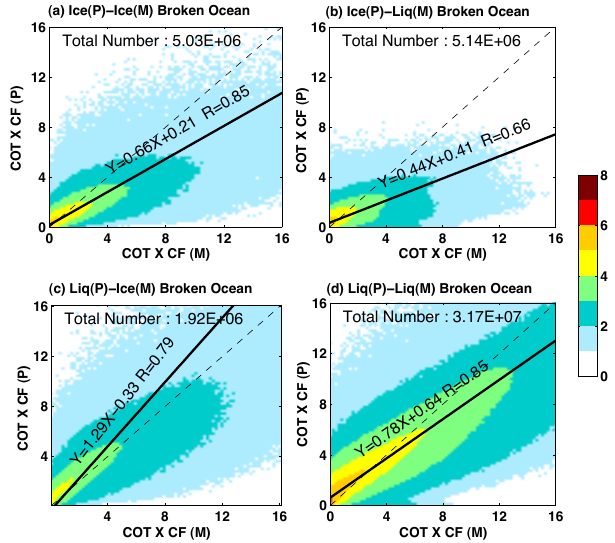
Fig. 5. Two-dimensional histograms of the product COT × CF of 4 different broken clouds over ocean separated by cloud com- bined phase. Color bars represent the logarithm of the pixel num- ber. Dashed lines are the one-to-one function lines meaning the POLDER COT equal to the MODIS one. Solid lines are the com- puted linear regression function of POLDER (y-axis) and MODIS (x-axis) COT × CF, with slopes and correlation coefficients ( R ) la- beled above the solid